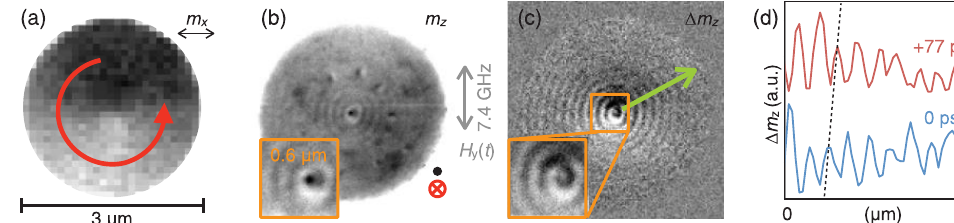
Figure 6. Example of spin-wave dynamics recorded using TimeMaxyne TR-STXM at MAXYMUS/BESSY II. ( a ) Magnetic vortex (red arrow) imaged with in-plane magnetic sensitivity (m X ). ( b , c ) Snapshots with perpendicular magnetic sensitivity of the response to a 7.4 GHz homogeneous alternating magnetic field excitation (grey arrow), zoom-ins of center regions in the bottom left corner. ( b ) Absolute contrast containing magnetic and non-magnetic absorption, ( c ) normalized contrast revealing only the magnetic changes. ( d ) Line profiles at different delay times along the green arrow in ( c ). Reprinted with permission from [45]. Copyright 2019 American Physical Society.